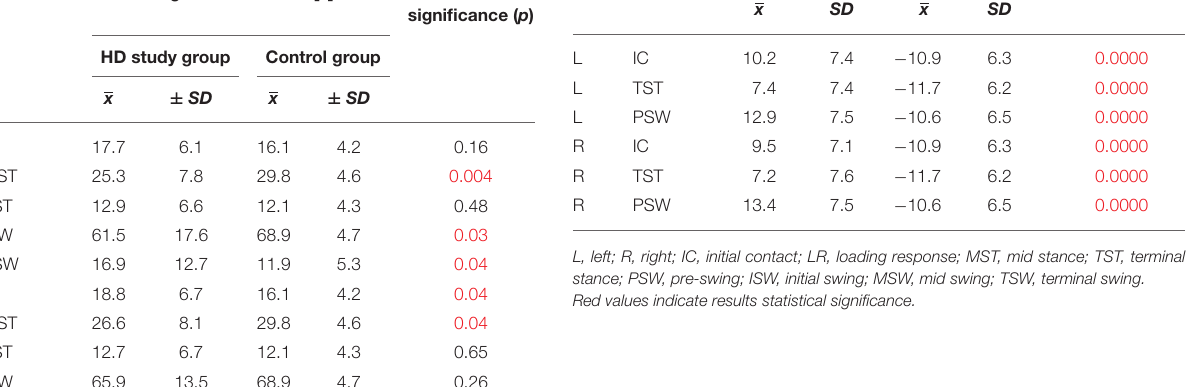
TABLE 4 | Angular changes in the knee joint compared with control group. Limb Gait Phase Angle of movement [ ◦ ] Statistical